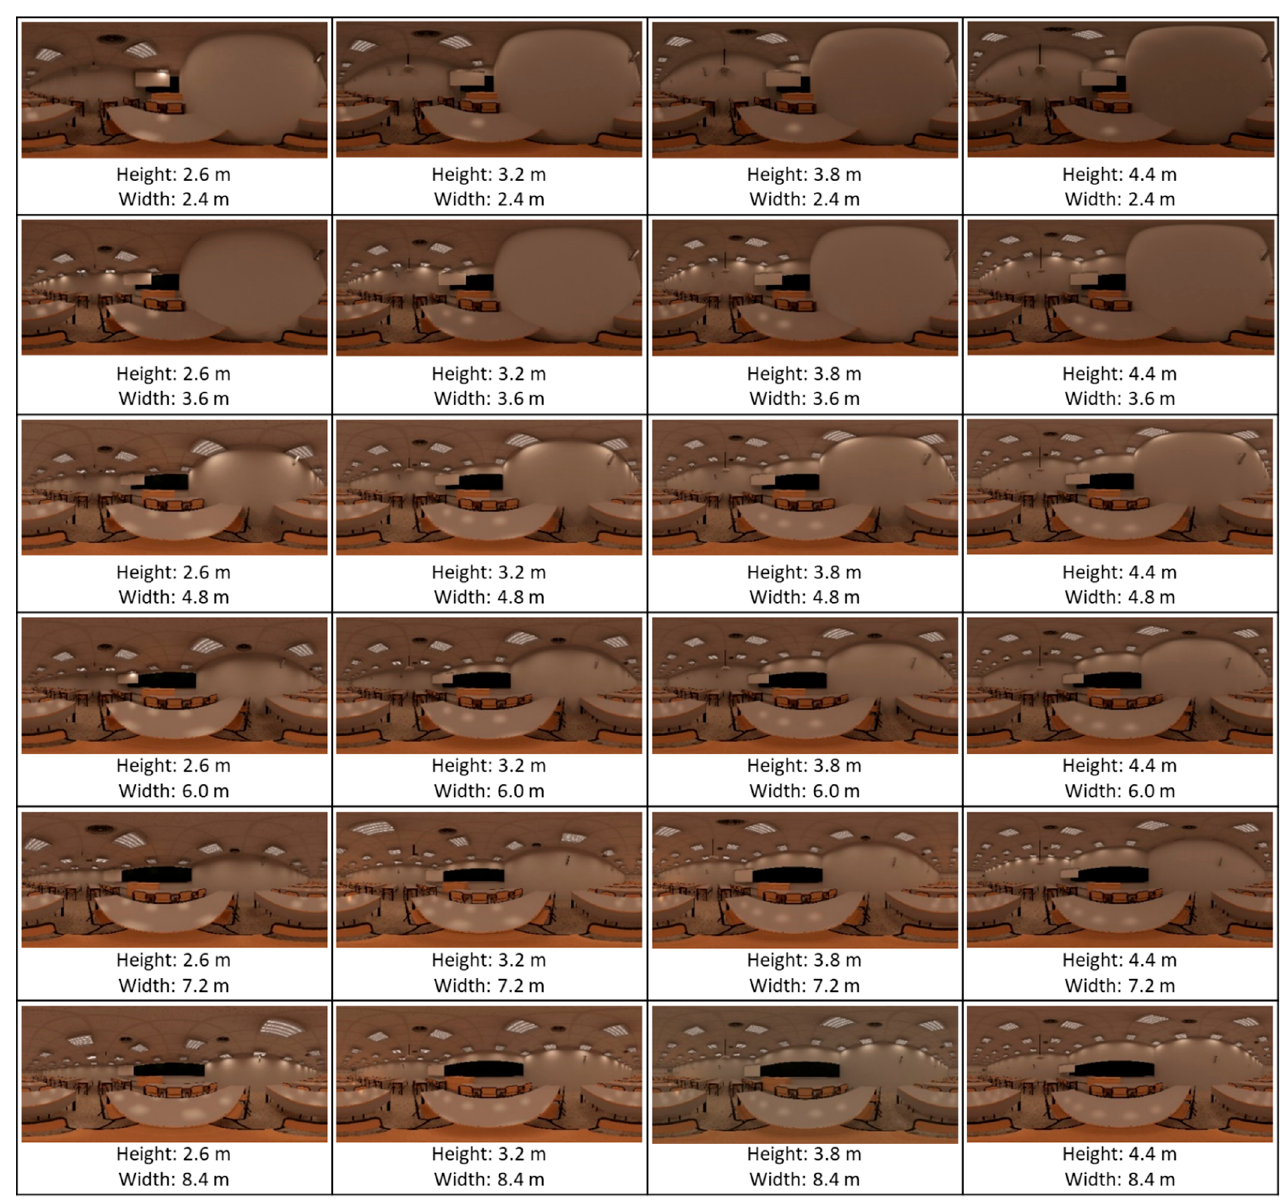
Figure 2. Virtual classrooms modified in geometry.